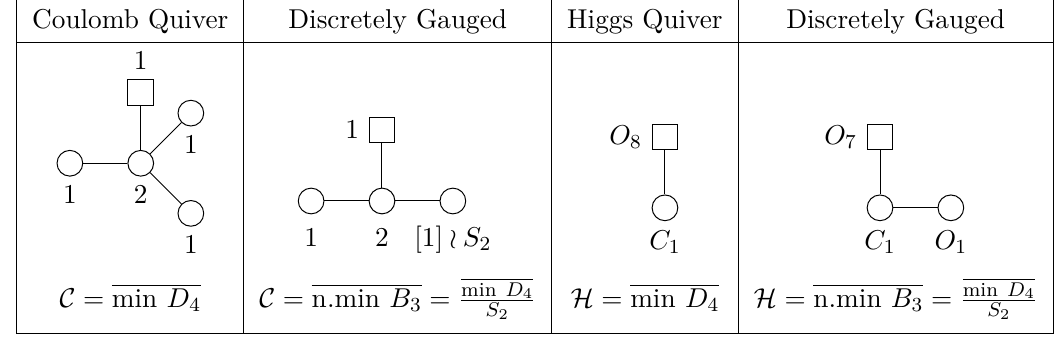
Table 8 . Illustration of the relation between i) discrete gauging’s effects on the Coulomb branch and ii) discrete gauging’s effects on the Higgs branch of a corresponding electric